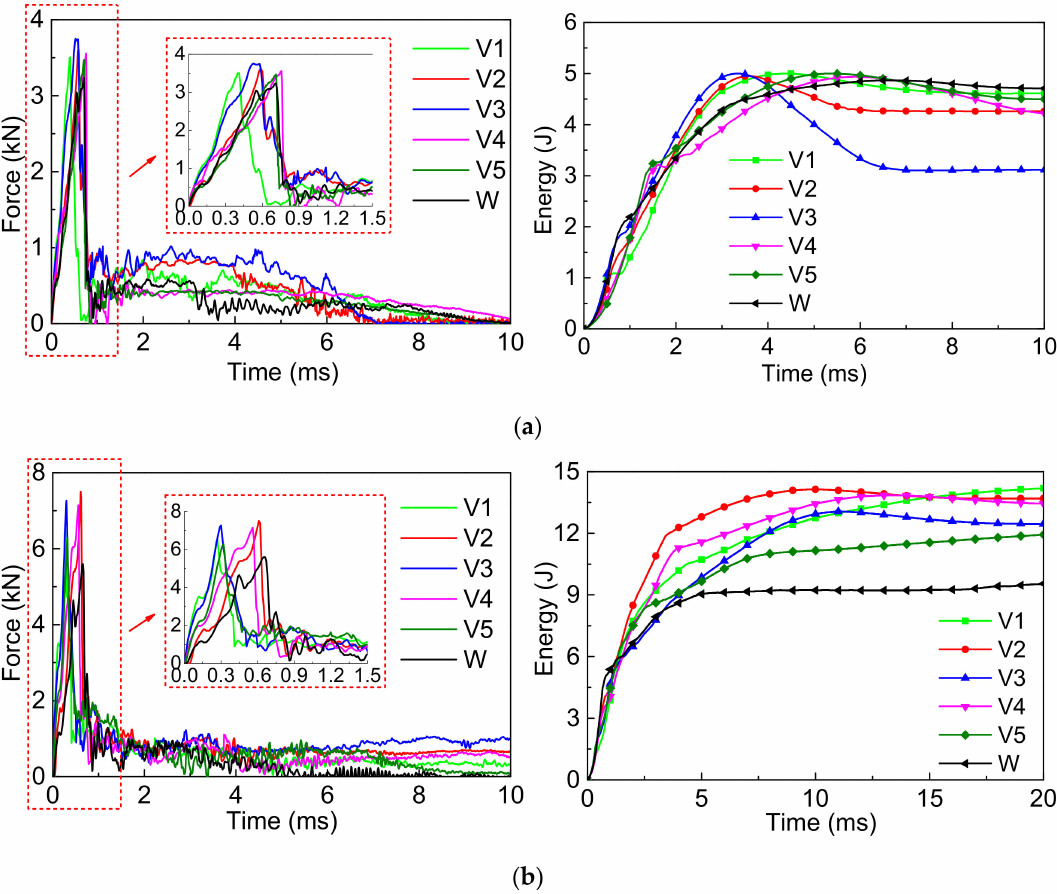
Figure 11. The force-time curves and energy-time curves of the composites with different SMA spacing under two impact energies: ( a ) Initial impact energy of 5 J; ( b ) Initial impact energy of 14